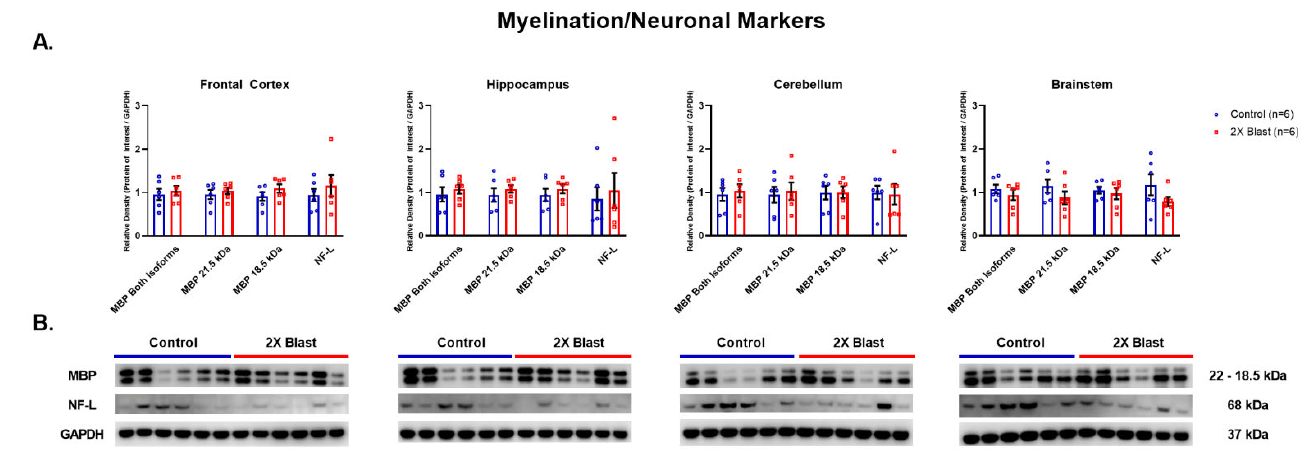
Figure 4. Myelin and neuronal related protein expression changes. ( A ) Densitometric ratio of the levels of MBP, isoforms 21.5 kDa and 18 kDa, (isoforms were evaluated together and separately) and NF ‐ L with respect to GAPDH as measured in the FCtx, H, CRB and BS 15 days following an explosive ‐ driven double blast exposure, n = 6 per group. Error bars represent standard error of the mean (SEM). ( B ) Representative western blots # for each antibody used. All gels were run in triplicate and data represents the average of 3 runs per sample. # For full length blots, see Supplementary Figures S8 and S9.